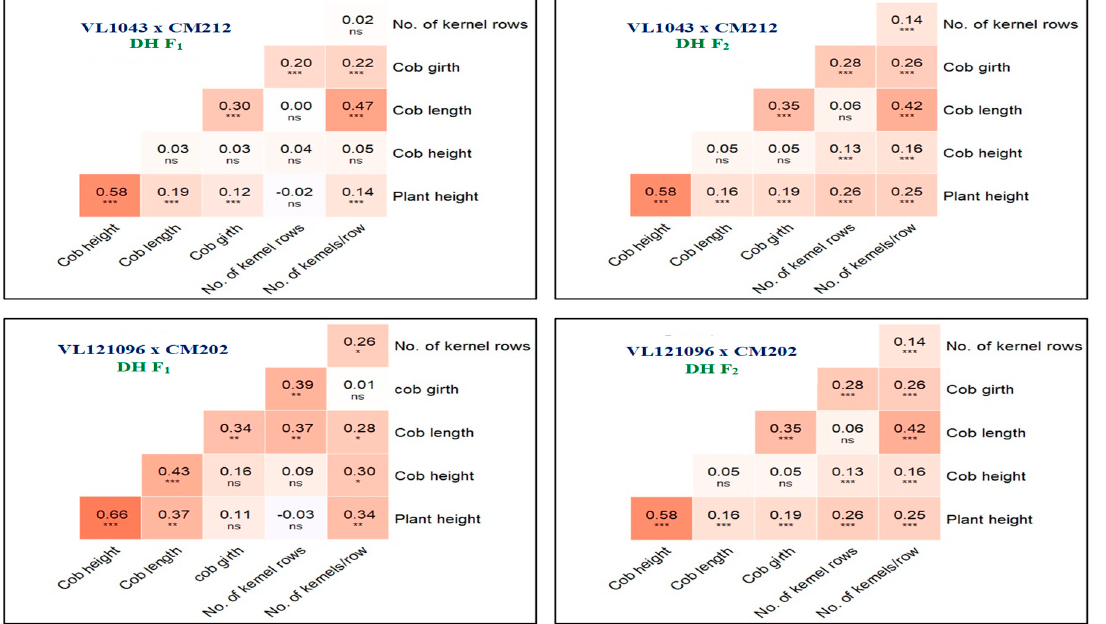
Figure 5. Correlation coefficients estimated among yield traits in DHF 1 and DHF 2 plants of crosses VL1043 × CM212 and VL121096 × CM202. Values with ns, *, ** and *** implies non-significance, significant at p = 0.05, p < 0.01 and p < 0.001, respectively.